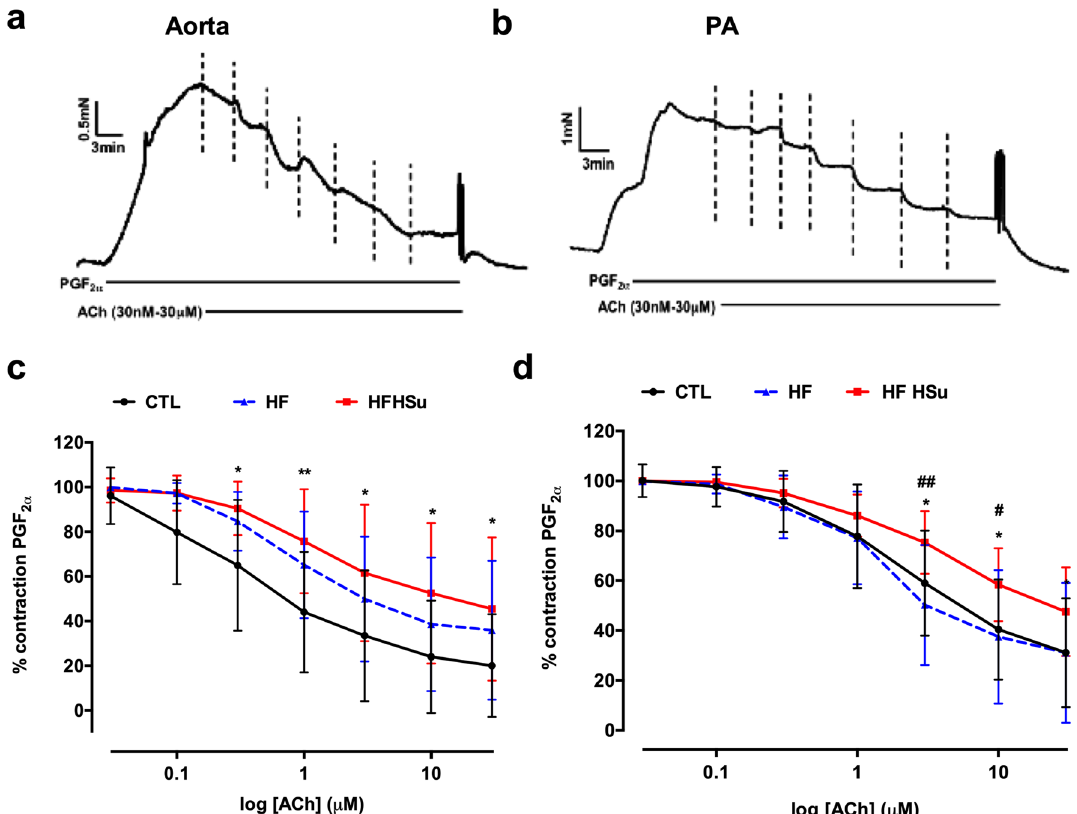
Figure 2. Effect of type 2 diabetes progression on endothelial function in aorta and pulmonary artery (PA). Typical trace of a dose response relaxation curve to different concentrations of ACh (0.03–30 µM) in the aorta ( a ) and pulmonary artery ( b ). Average responses in the aorta ( c ) and pulmonary artery ( d ) of the dose response relaxations in control (n = 10–14), HF (n = 10–11) and HFHSu (n = 10) animals. Values are presented as mean ± SD. Curves compared using two-way ANOVA with Dunnet’s Multiple Comparison test. * p < 0.05 and ** p < 0.01 versus control animals; # p < 0.05 and ## p < 0.01, HF versus HFHSu